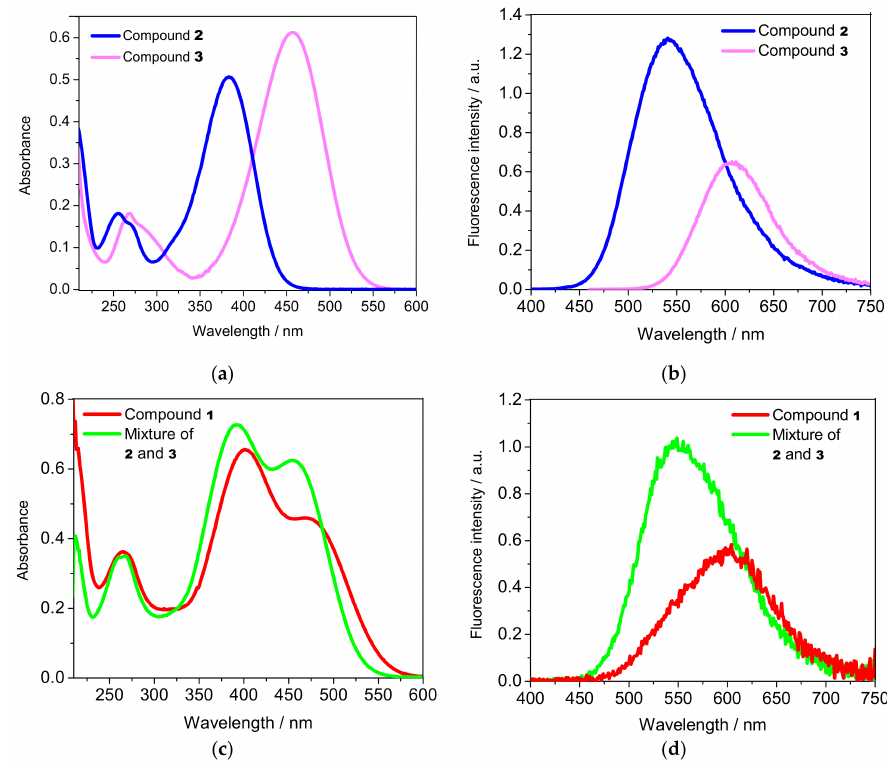
Figure 1. Absorption ( a , c ) and fluorescence ( b , d ) spectra of compounds 1 ( c , d ), 2 ( a , b ), 3 ( a , b ), and equimolar mixture of 2 and 3 ( c , d ) in water at pH 6.0 (acetate buffer, 10 mM). Concentrations of all compounds 20 µ M. Excitation wavelengths λ ex were 450 nm for 3 and 380 nm for 1 , 2 , and mixture of 2 and 3 . Table 1. Spectral characteristics of compounds 1 , 2 , and 3 and stability constants of their complexes a with Hg 2+ in water at pH 6.0 (10 mM acetate buffer) a